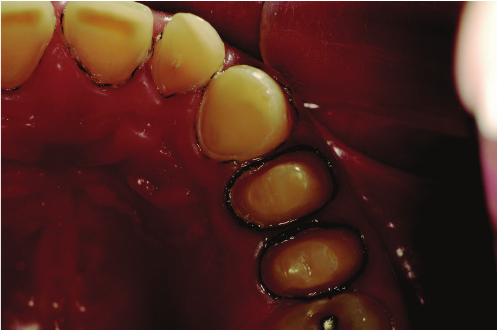
Figure 10: Clinical aspect of the conditioned inner face of the laminate veneers.